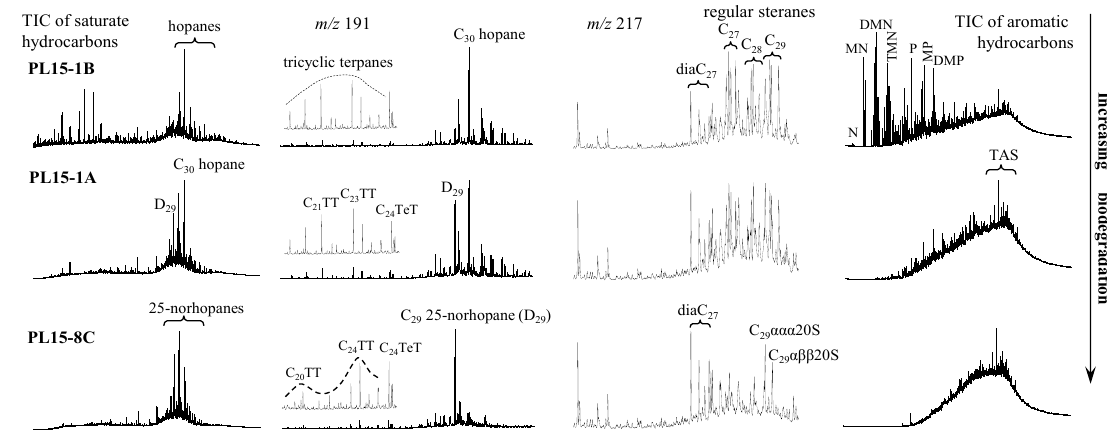
Figure 1. Total ion chromatogram (TIC) of aliphatic fractions, partial m/z 191 mass chromatograms for tricyclic and pentacyclic terpanes, partial m/z 217 mass chromatograms for regular steranes and diasteranes and TIC of aromatic fractions for the studied oils showing increasing degree of biodegradation